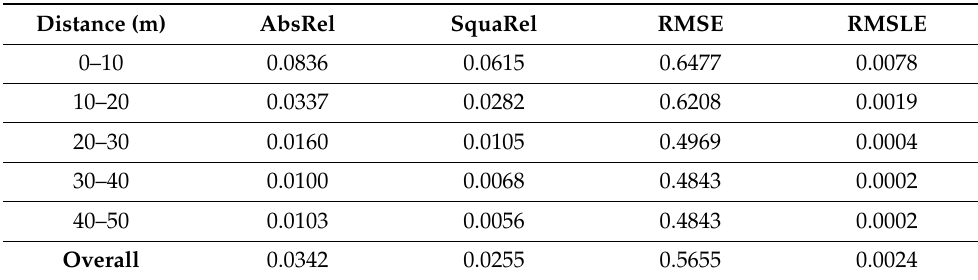
Table 2. Distance accuracy verification by comparing ground truth data with the estimated dis- tances.